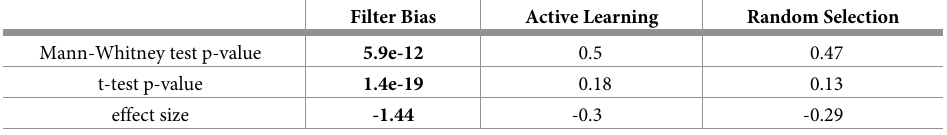
Table 3. Results of the Mann-Whitney U test and t-test comparing the size of the all-classes-blind spot for the three forms of iterated algorithmic bias. The effect size is conducted as ( BlindSpot | t = 0 − BlindSpot | t = 200 )/ standard . dev . The negative effect size shows that filter bias increases the class-1-blind spot size. On the other hand, both active learning and random selection have no significant